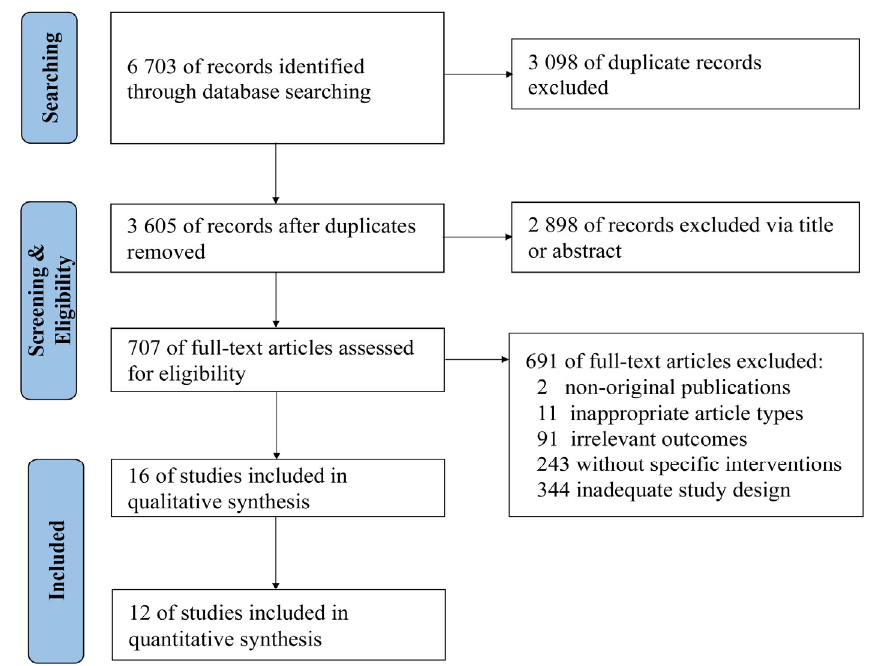
Figure 1. Flow diagram of study identification and screening.